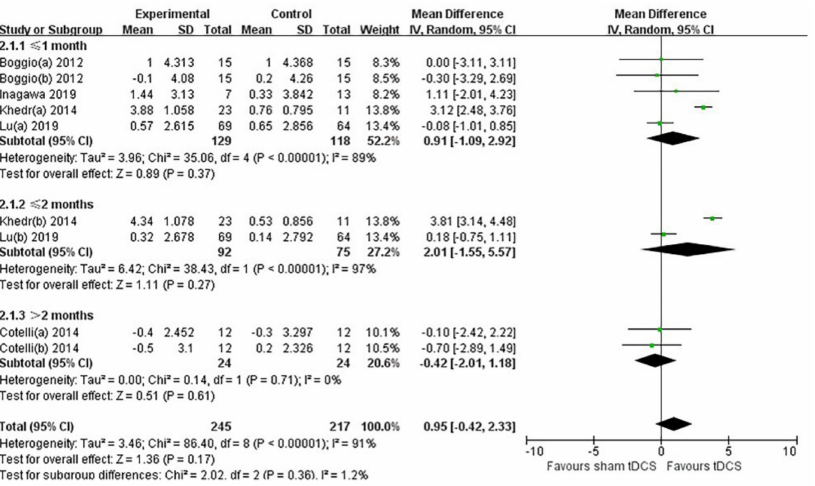
Figure 6. Forest plots of the effects of tDCS on MCI or mild-to-moderate AD patients at different time points after treatment. The order of references is [37,38,40,40–46,51]. The results of different follow-up times in the same study are represented by (a) and